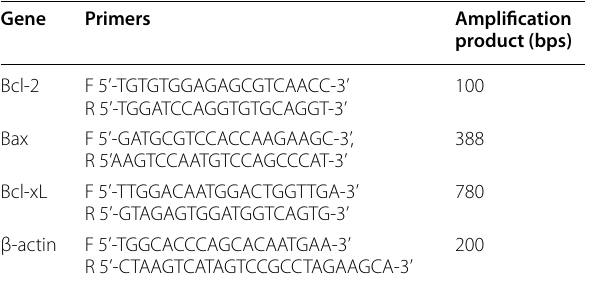
Table 1 List of specific primers for apoptotic